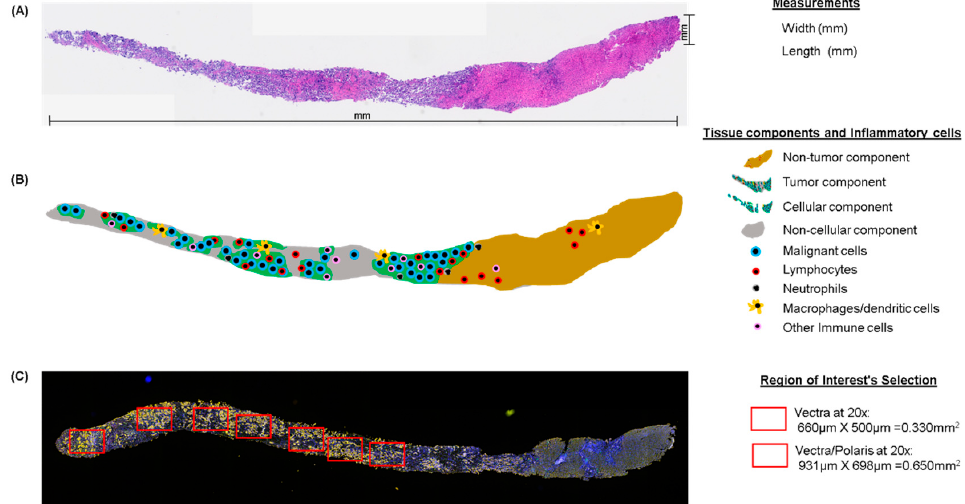
Figure 3. Microphotographs of hematoxylin and eosin (H&E), multiplex IF, and schematic representation of tissue quality components in longitudinal studies. ( A ) Principal measurements on a core needle biopsy with H&E. ( B ) Schematic of the same core needle biopsy showing the principal compartments and inflammatory evaluation during the pathology quality control of the sample. ( C ) Multiplex IF microphotograph showing the selection of regions of interest in the same core needle biopsy. H&E and multiplex IF are at 4× magnification.